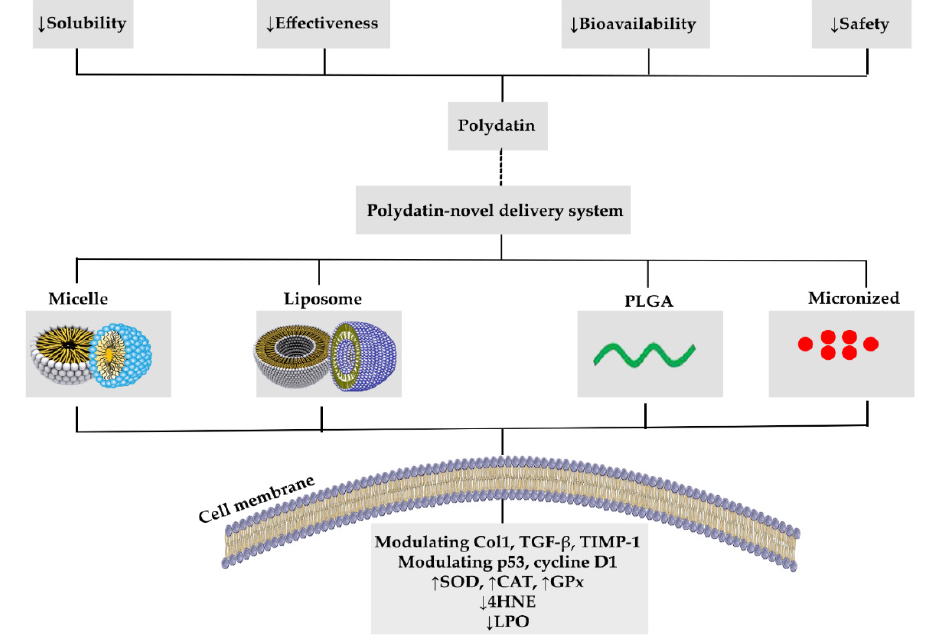
Figure 3. Novel delivery systems of polydatin: Reduction in the pharmacokinetic limitations.